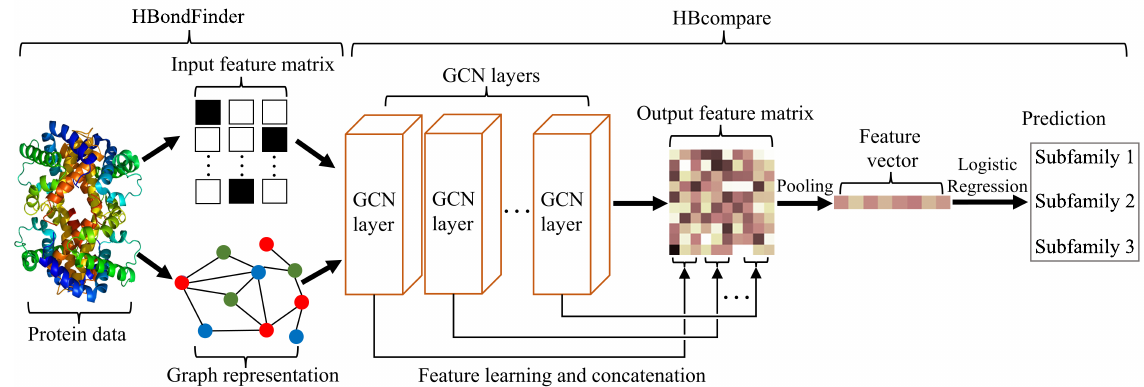
Figure 1. The HBcompare model. As input, HBondFinder takes protein structures and constructs the feature matrix and graph representation. Next, these data are analyzed using GCN layers and their results are concatenated to generate the output feature matrix, which is vectorized via graph pooling and fed to a logistic regression (LR)